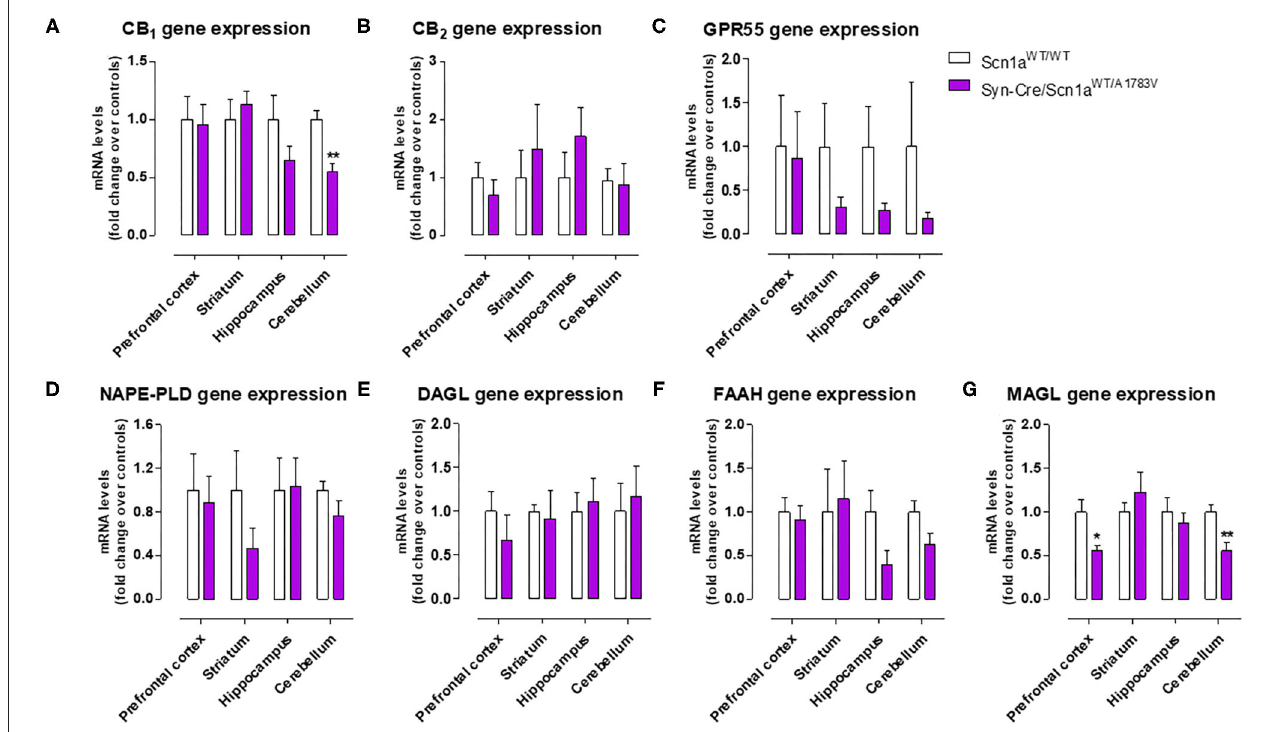
FIGURE 10 | Gene expression for the CB 1 , CB 2 , and GPR55 receptors and the NAPE-PLD, DAGL, FAAH, and MAGL enzymes measured by qPCR in different CNS structures of Syn-Cre/Scn1a WT / A1783V mice compared with Scn1a WT / W animals at PND25. Values are fold of change over controls and correspond to means ± SEM of five to six animals per group. Data were assessed by the Student’s t -test (* p < 0.05, ** p < 0.01 vs. the control